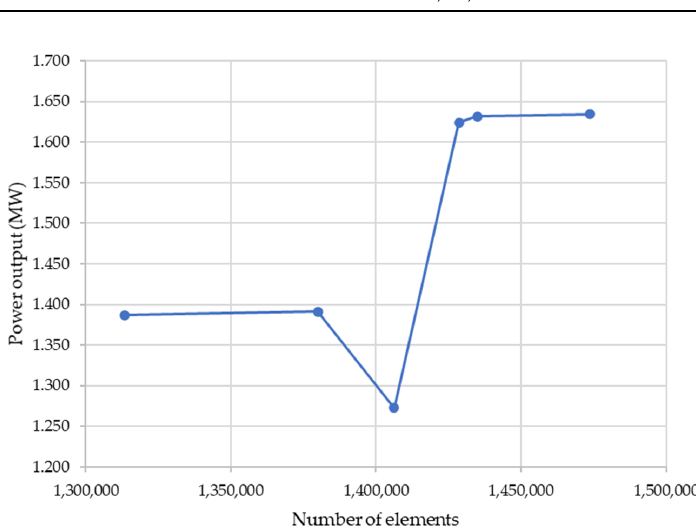
Figure 3. HAWT power output versus number of elements.